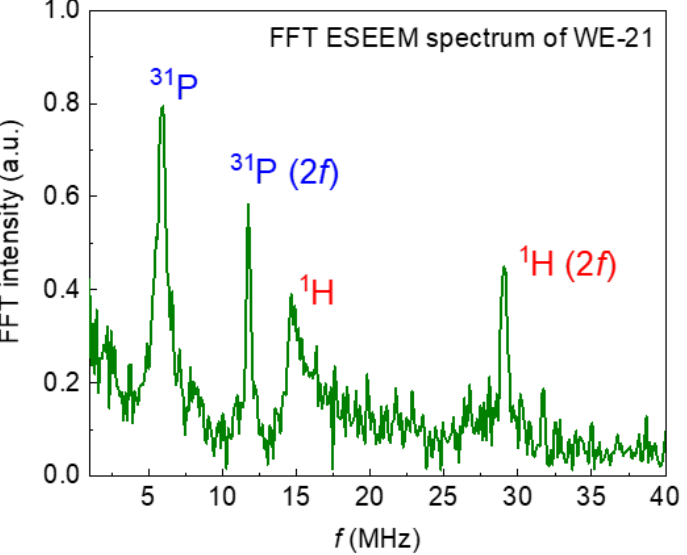
Figure 9. The spectrum of electron–nuclear interactions obtained by the ESEEM pulse sequence. Resonant absorptions in the frequency domain correspond to nearby magnetic nuclei that interact with the nitrogen radical in the crystal lattice of the sample. The (2f) indicates second-harmonic modulation. Based on the EPR results, it can be argued that the magnitude of the hyperfine inter- action A decreases after 21 days of ripening, and the EPR lines become narrower and more resolved (see Table 4). A similar effect is due to the fact that, during ripening, nanoparticle material becomes more crystallized, with fewer defects (dislocations) in the crystal lattice, as confirmed by XRD results. It is worth noting that both components of hyperfine